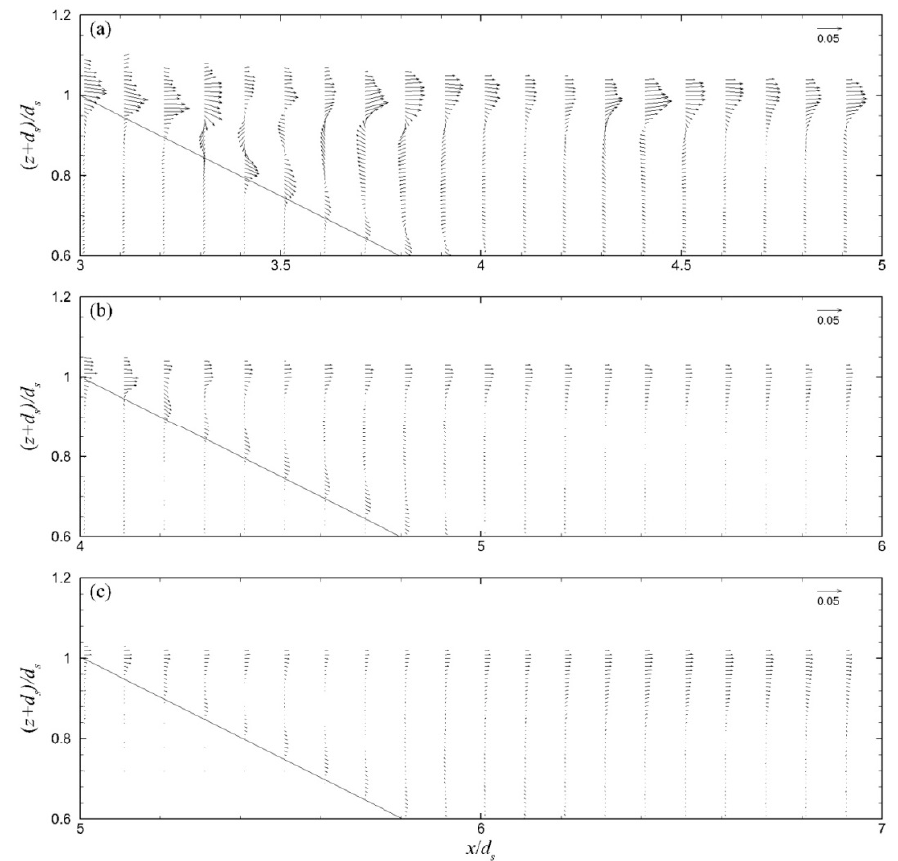
Figure 11. Period-mean velocity field in the leeward region of the ZFBs in cases: ( a ) 1, ( b ) 2, and ( c ) 3. Velocity vectors are shown non-dimensionalized by ( gd S ) 1/2 in the water phase under the wave crest envelope.